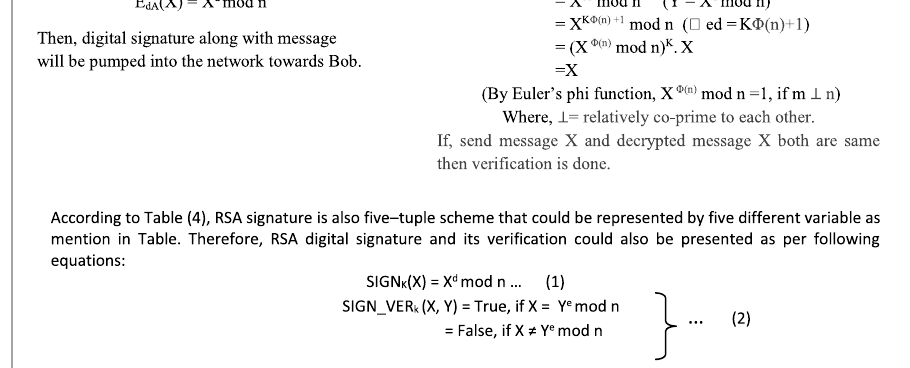
Fig. 7 RSA digital signature: creation and